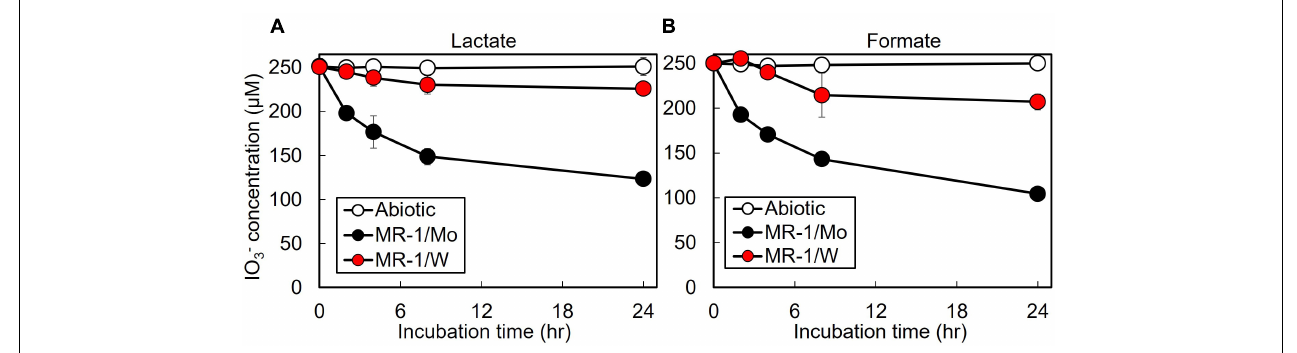
FIGURE 3 | Effect of molybdenum (Mo) substitution with tungsten (W) on IO 3 − reduction activity of Shewanella oneidensis with IO 3 − as the electron acceptor and (A) lactate or (B) formate as the electron donor. Values are means of triplicate samples from anaerobic incubations. Error bars represent one standard deviation. TABLE 2 | Effect of replacement of molybdenum (Mo) with tungsten (W) on IO 3 − reduction activities of Shewanella oneidensis . a Condition or strain Electron donor: lactate Electron donor: